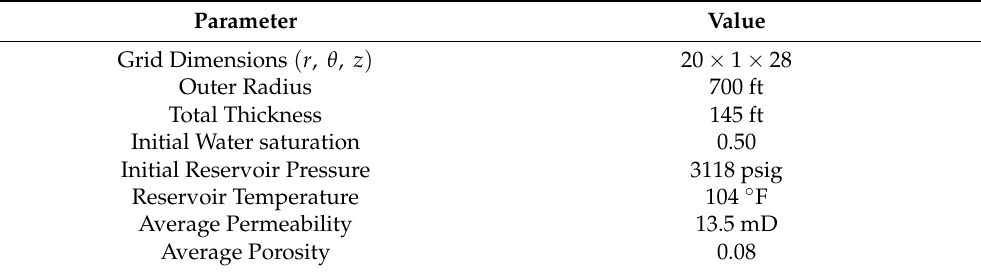
Figure 4. ( a ) Top view of the radial model. The injection well was placed in the center of the grid. ( b ) Permeability distribution of a 2D slice ( r − z ) of the radial simulation model. Properties were derived from the last step of the history matched sector model. Table 3. Radial model